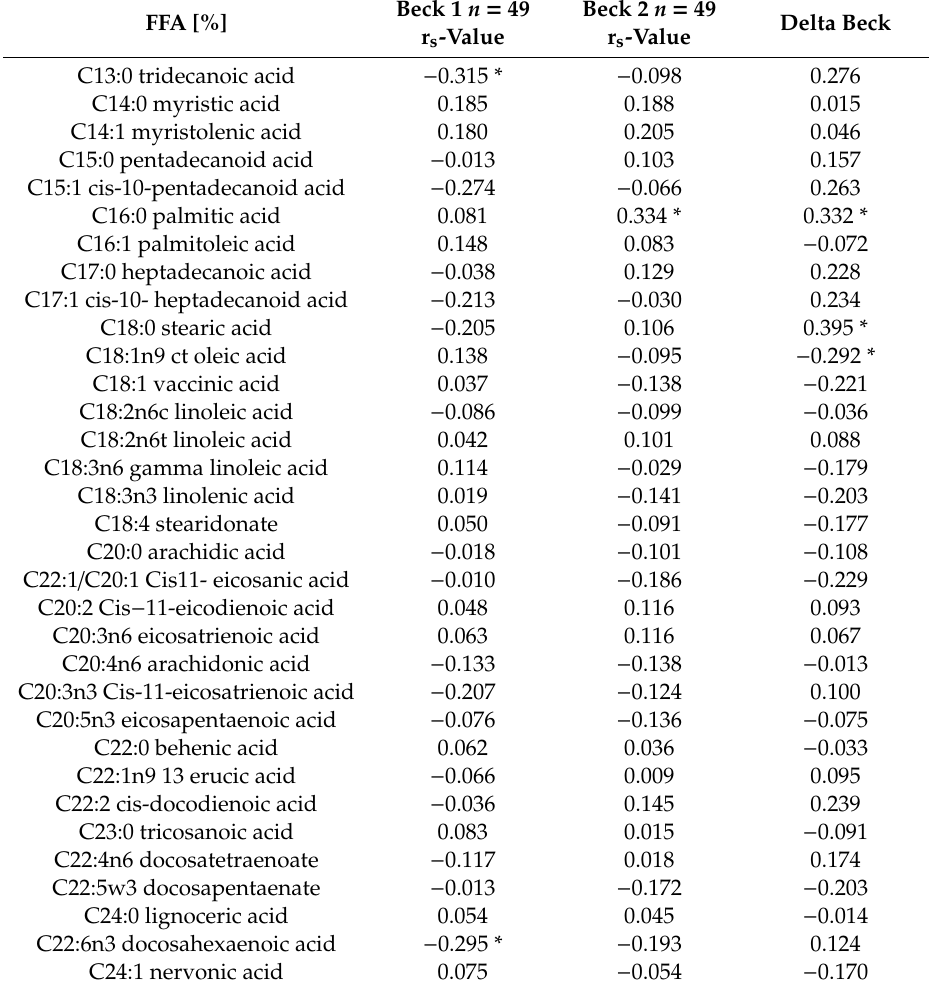
Table 3. The association between FFA and BDI-II score obtained on 7th day (Beck 1) and in follow-up after 6 months (Beck 2), and delta